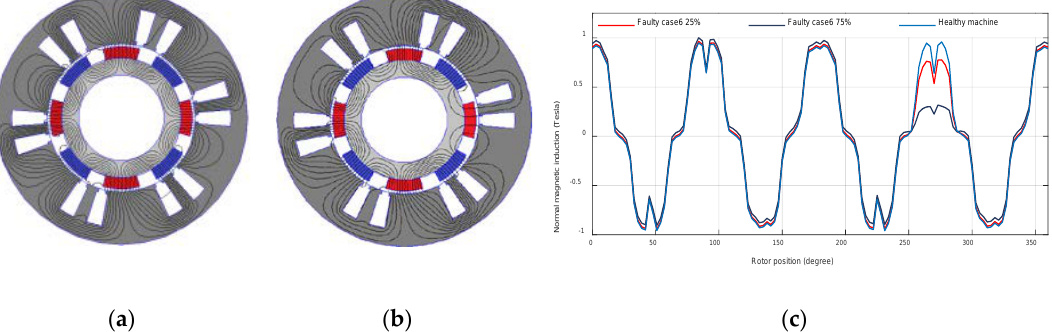
Figure 14. Faulty case 6: ( a ) Magnetic field under 25%; ( b ) magnetic field under 75%; ( c ) airgap magnetic flux density.